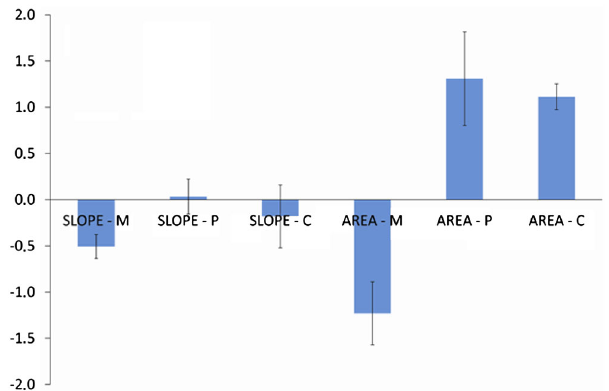
FIG. 3 (color online). Average difficulties of slope and area items in three different domains ( M stands for mathematics without context, P for physics, C for other contexts). All values are in logit. Error bars indicate the combined uncertainties of each average value computed as CE ¼ ð SEM 2 þ SE 2 Þ 1 = 2 , where SEM is standard error of the mean and SE is the average Rasch standard error.